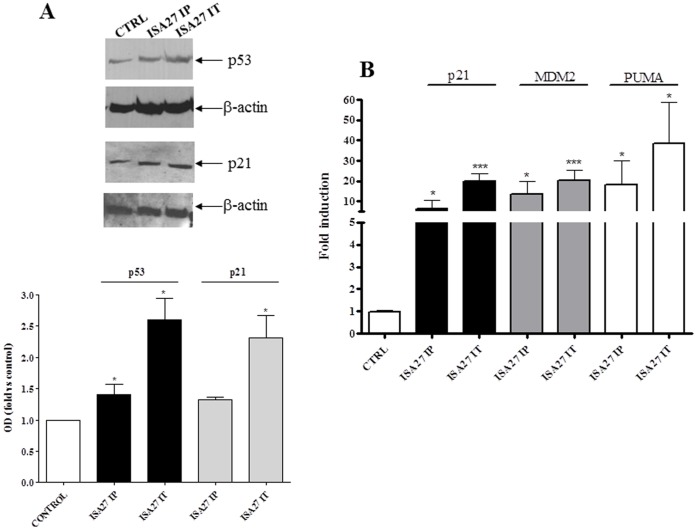
ISA27 activates p53 in vivo.Tumors were harvested from mice of different ISA27 treatment groups (IP = intraperitoneal treatment; IT = intratumor treatment), processed to obtain cell lysates for Western blot and total RNA for real-time RT-PCR analysis. A) Western blot analysis showed up-regulation of p53 and p53 transcriptional target p21 in tumors from ISA27 IT group and up-regulation of p53 in tumors from ISA27 IP group. In this group, the increase of p21 was near to significance. B) Real-time RT-PCR analysis showed a statistically significant increase in MDM2, p21 and PUMA mRNA levels in tumors from ISA27 IT and IP groups.